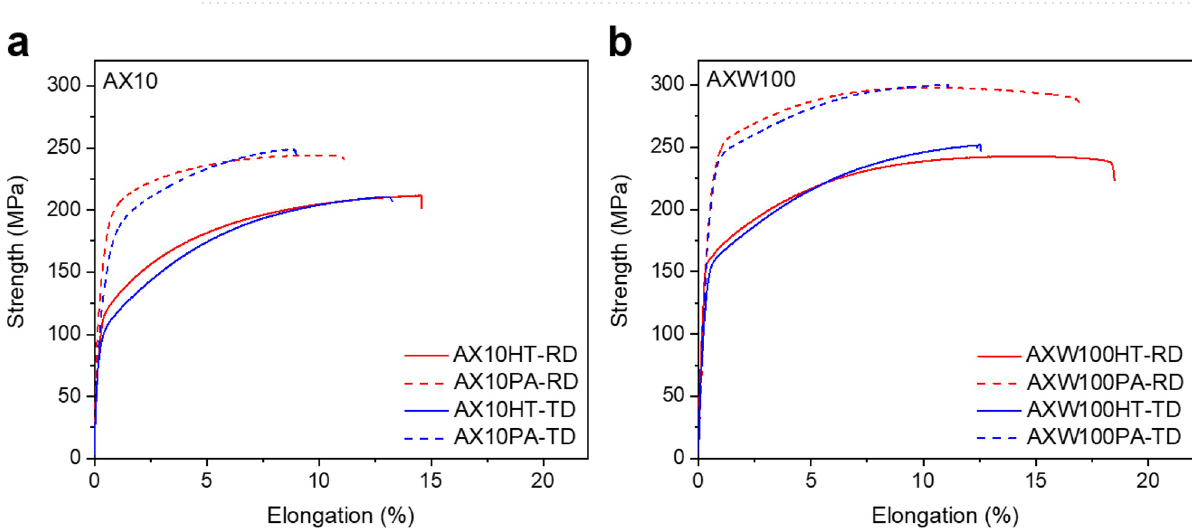
Figure 3. Tensile properties of the homogenized and peak-aged ( a ) AX10 sheets and ( b ) AXW100 sheets along the RD and TD at room temperature. Red and blue curves indicates the curves of the investigated alloy sheets along the RD and TD, respectively. The solid and dotted lines present the curves of the homogenized and peak-aged alloy sheets, respectively. HT indicates the homogenized samples heat-treated at 500 °C for 3 h. PA indicates the peak-aged samples heat-treated at 250 °C for 1800 s following the homogenization